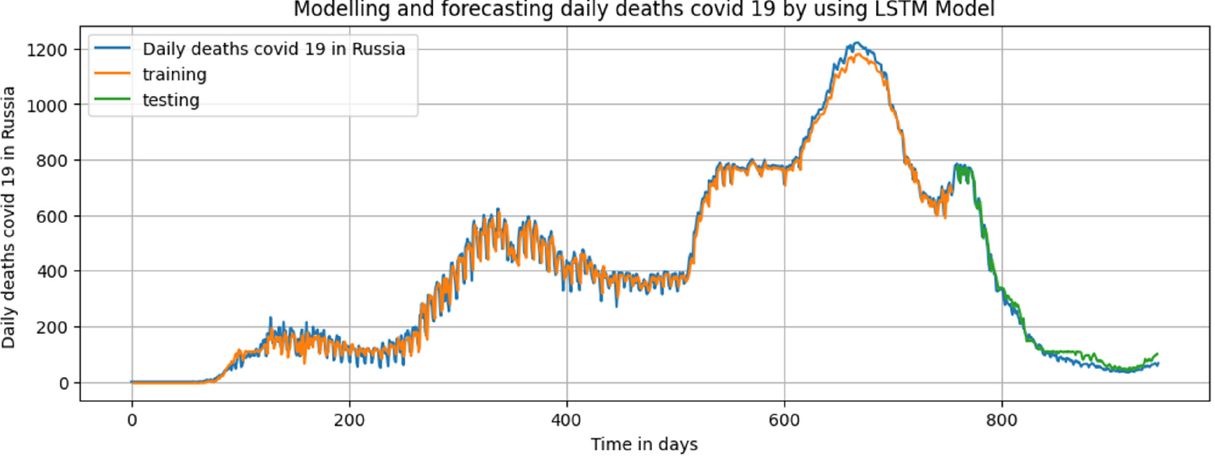
Figure 11. Comparison of the forecasting SARS-CoV-2 death cases and the real infection cases for LSTM.